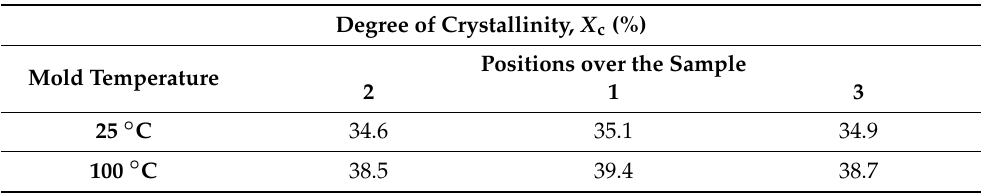
Figure 6. FESEM images of the cross section of 3 wt%-MWCNT T-100 °C samples in P2 and P3. Table 2. Degree of crystallinity of 3 wt%-MWCNT nanocomposites as a function of mold temperature in the different positions over the